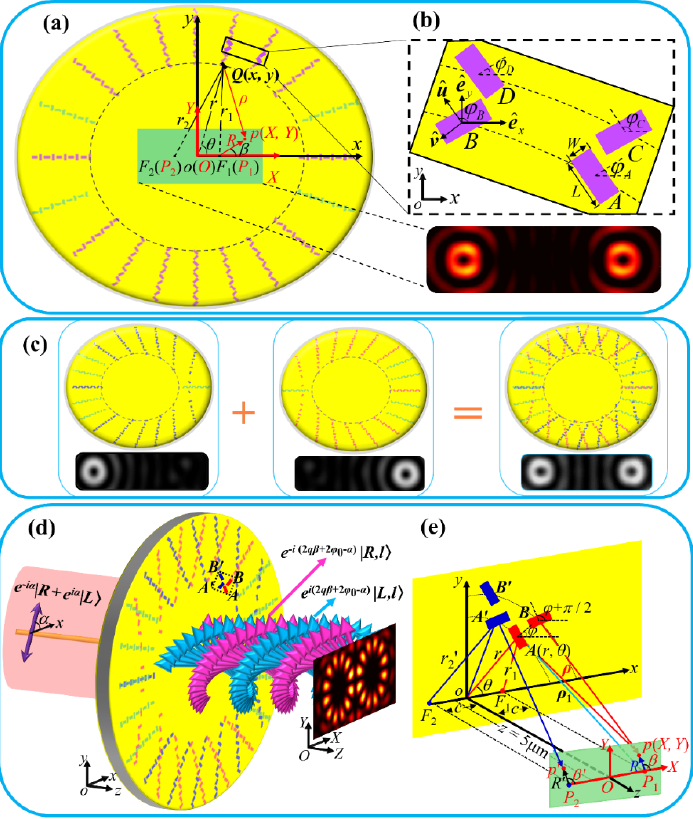
Figure 1. Schematic geometry for plasmonic metasurface based on the elliptic curve to generate dual-channel FVBs. ( a ) Schematic of a metasurface composed of the nanoslits to generate the in-plane dual-channel FVBs at the two foci. ( b ) Enlarged view and geometry of the nanoslits at the in-phase point and the out-of-phase point on two adjacent ellipses. ( c ) Design principle for metasurface generating dual-channel FVBs in observation plane at a certain distance away from the metasurface. ( d ) Schematic for generating dual-channel FVBs under illumination of linearly polarized light. ( e ) Geometry for light propagations in dual-channel FVBs